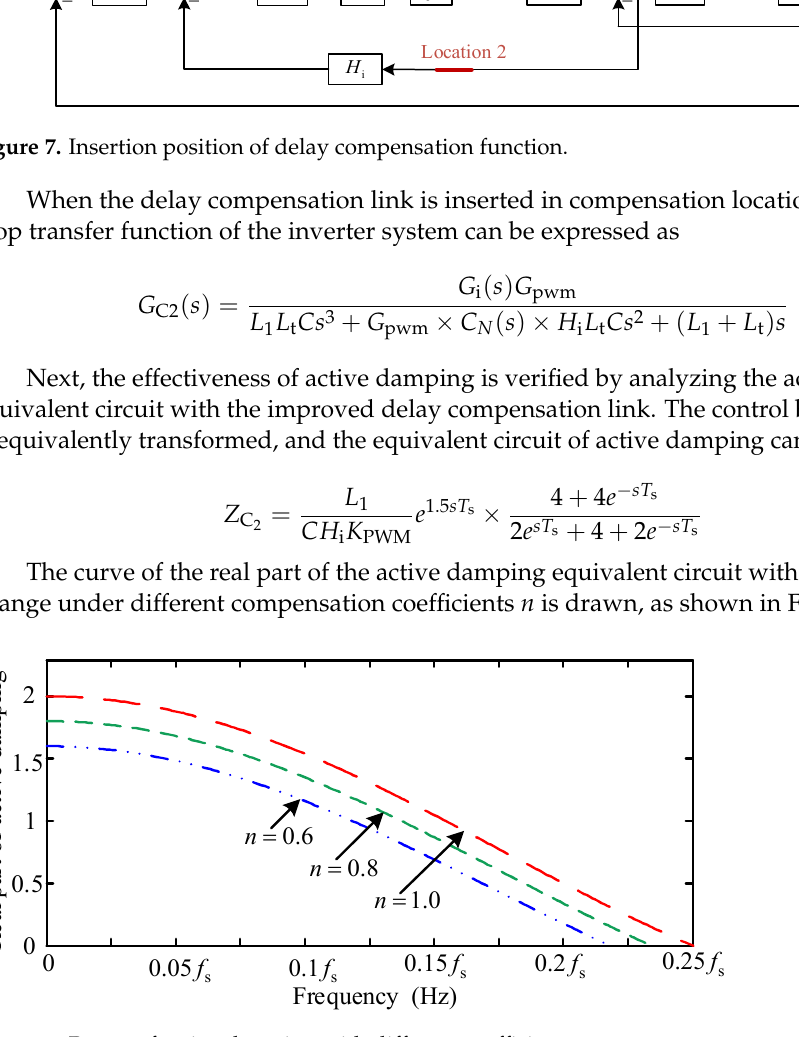
Figure 6. Comparison of new delay compensation function with first-order lead link.